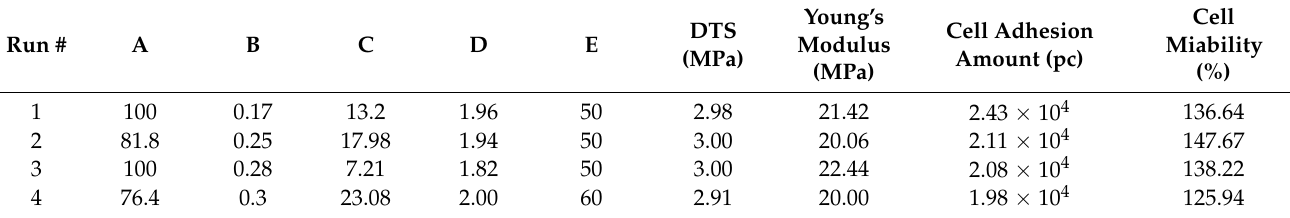
Table 8. The optimal factor-level combination.